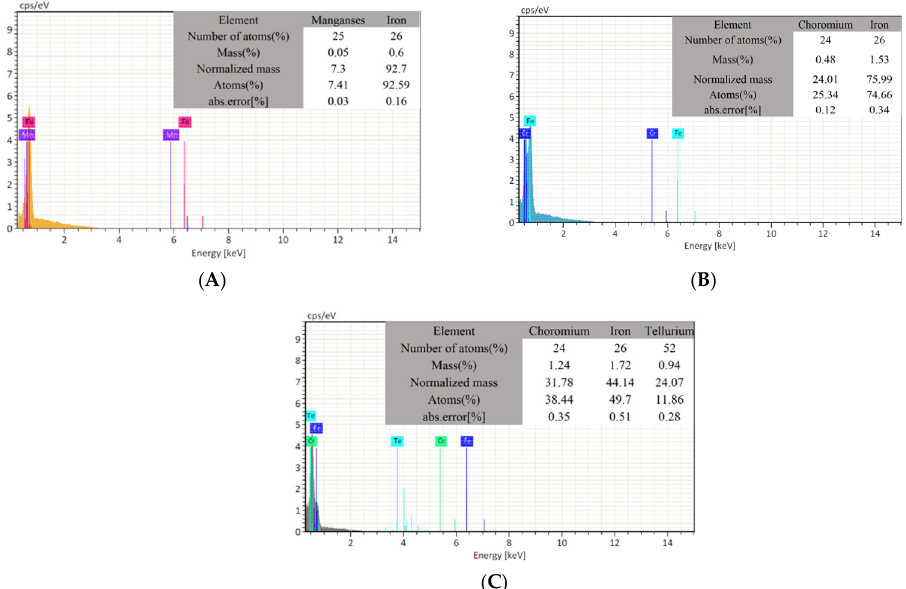
Figure 21. EDS spectrum analysis results of metamorphic layer. ( A ) EDS spectrum analysis of metamorphic layer; ( B ) EDS spectrum analysis of transition zone; ( C ) EDS spectrum analysis of substrate material.